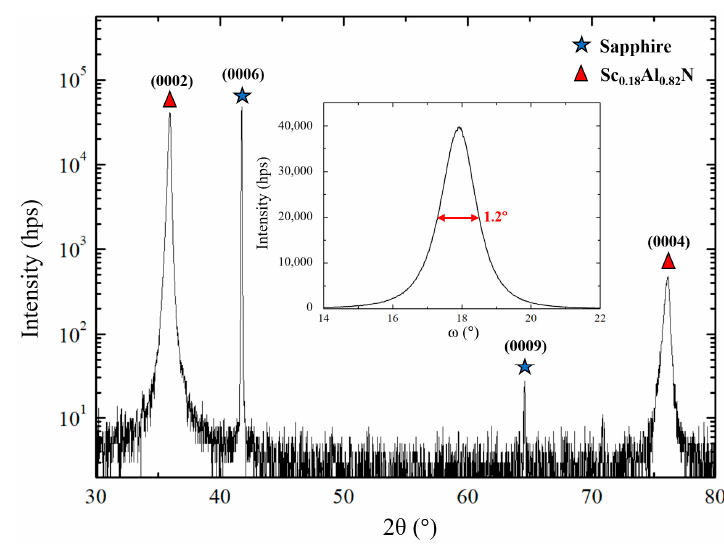
Figure 3. θ -2 θ diagram of a Sc 0.09 Al 0.91 N thin film deposited on a 650 °C heated sapphire substrate, with a plasma pressure of 7 mTorr. The inset figure shows the rocking-curve of the (0002) orientation.